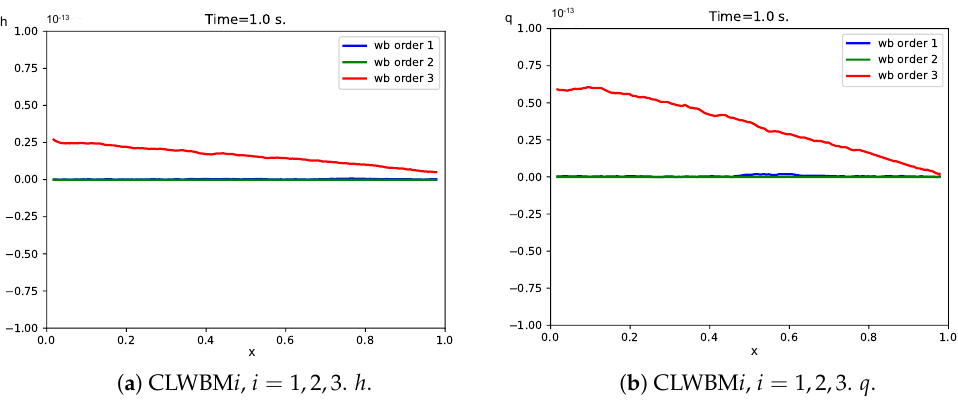
Figure 9. Test 4.1. Differences between the stationary and the numerical solutions for CLWBM i , i = 1,2,3 at time t = 1 s for a 200-cell